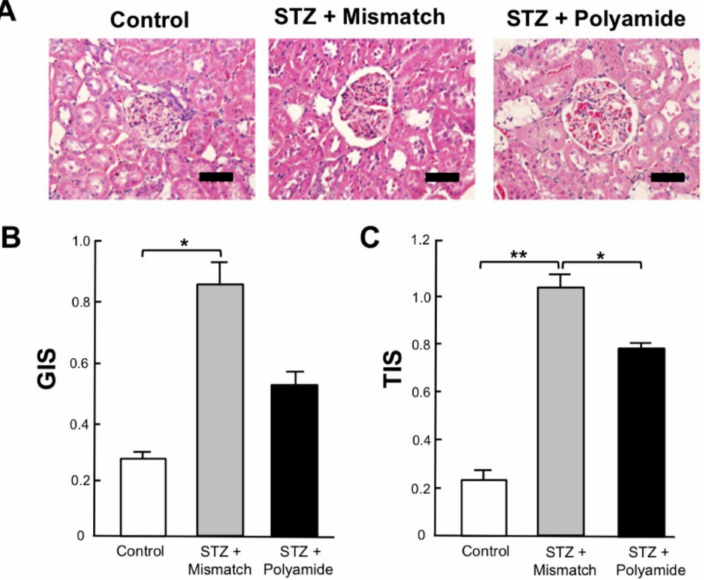
Figure 7. E ff ects of pyrrole-imidazole (PI) polyamide targeting TGF- β 1 on renal injury in streptozotocin (STZ) diabetic rats at 3 months after STZ injection. Diabetes was induced in male Wistar rats by single intraperitoneal injection of 60 mg / kg body weight of STZ. Control rats were intraperitoneally injected with 1 mL of 0.1% acetic acid. Five milligrams of PI polyamide targeting TGF- β 1 or Mismatch polyamide dissolved in 1 mL of 0.1% acetic acid was intraperitoneally injected twice a week for 3 months, and then the rats were sacrificed to remove their kidneys. ( A ) The 3-mm para ffi n sections of removed renal cortex were stained with hematoxylin and eosin. Scale bar indicates 25 µ m. ( B ) Glomerular injury score (GIS). ( C ) Tubulointerstitial injury score (TIS). Data are the mean ± SEM ( n = 8). * p < 0.05, ** p < 0.01 between indicated